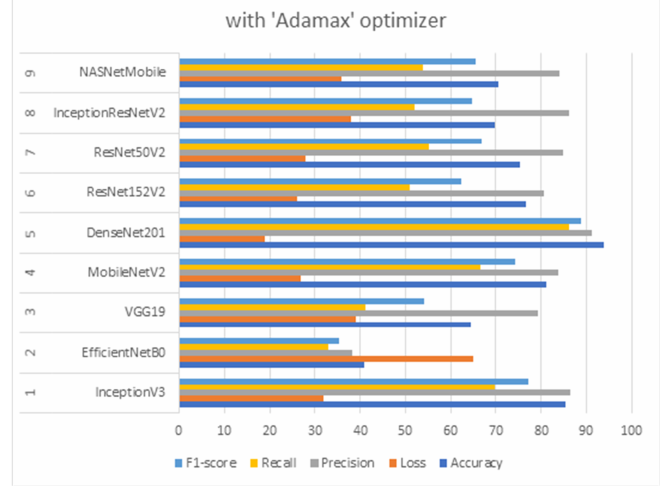
Figure 7. Comparative analysis of classification metrics obtained using transfer-learning techniques with Adamax